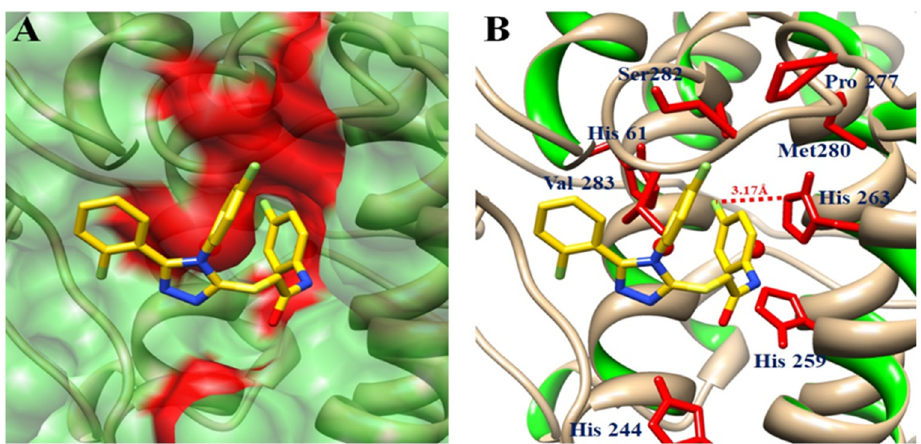
Figure 7. ( A ) Molecular docking interaction of 9h with the target protein. The binding conformation of 9h is highlighted at the active site of the target protein. Red color shows the binding pocket and residues involved in binding interactions. ( B ) The ligand is highlighted in yellow while the functional groups such as oxygen, amino group, sulfur, and fluorine are shown in red, blue, yellow, and light green colors, respectively. Red dotted line with the distance shown in angstrom (Å) represent the hydrogen bond and its distance. Two copper ions are represented by light red circles.